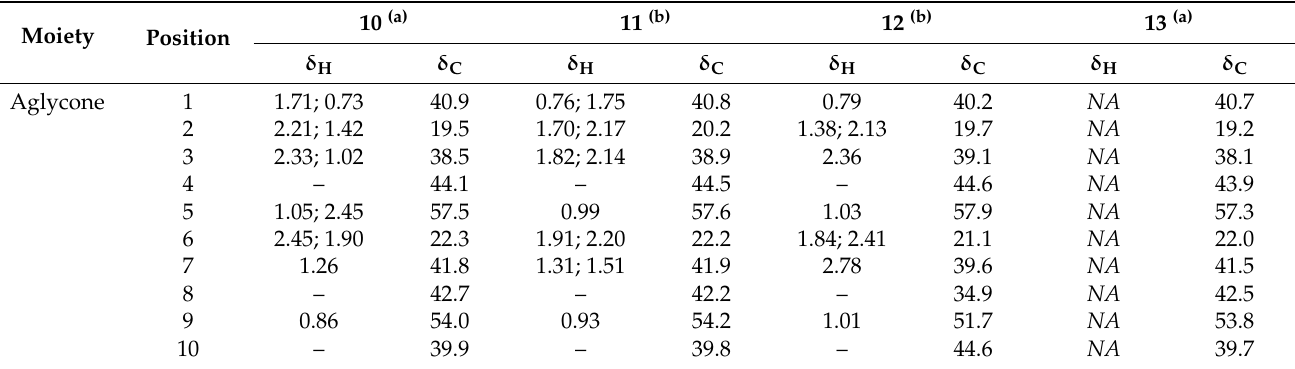
Table 5. 1 H and 13 C chemical shifts of the compounds 10 – 13